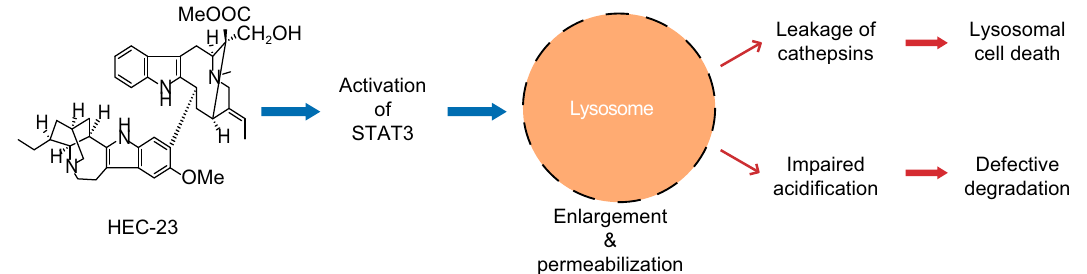
Figure 7. Schematic diagram of HEC23-induced lysosomal enlargement and cell